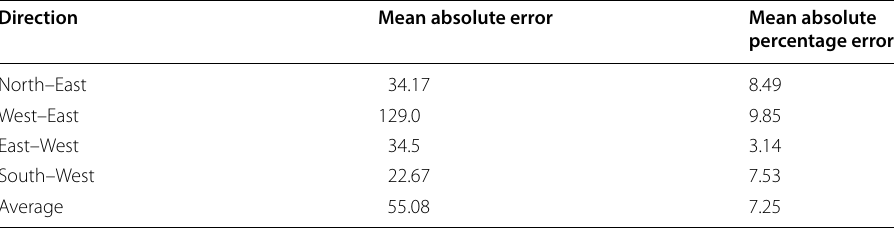
Table 3 Mean absolute error and mean absolute percentage error per hour for the